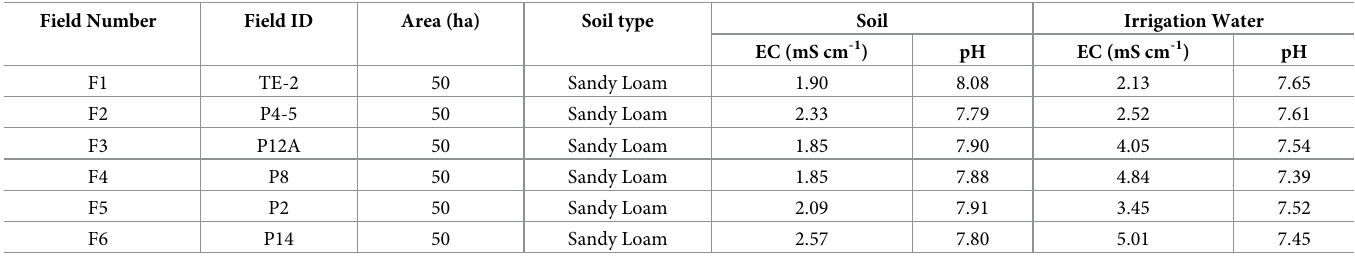
Table 1. Description of the experimental